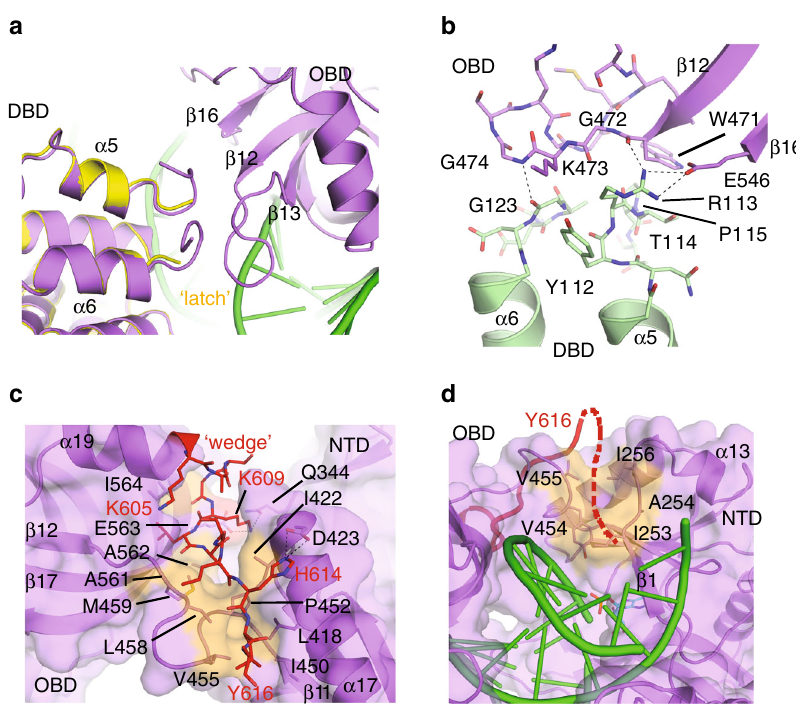
Fig. 4 Striking structural features of the LigIV catalytic domain. a Comparison of the “ latch ” (orange) in the open (yellow) and closed DNA – adenylate complex (protein in purple, DNA in green). b Details of “ latch ” interactions between the DBD (green) and OBD (purple) subdomains, with protein sidechains drawn in stick. c Disposition of the “ wedge ” motif. The C-terminal tail (red) becomes ordered in the closed conformation, and covers a hydrophobic channel (orange) between the OBD and NTD subdomains, the potential trajectory of which continues along the protein surface toward the downstream DNA (green) duplex ( d ). Putative hydrogen-bonding interactions are indicated by black dashed lines. A detailed list of “ latch ” interactions